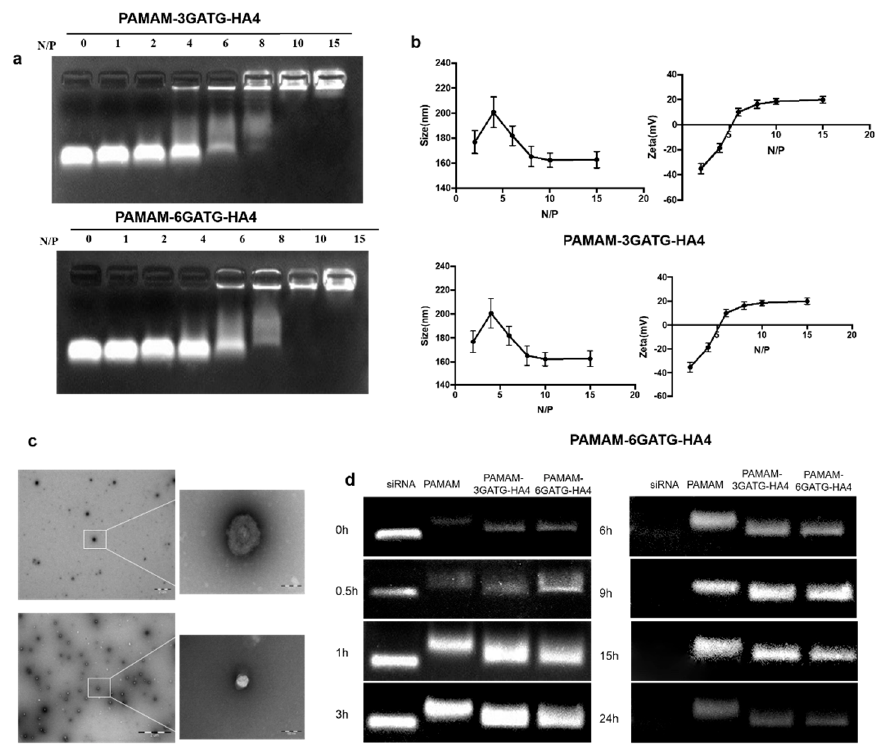
Figure 2. ( a ) Agarose gel electrophoresis of PAMAM-3GATG-HA4/siRNA and PAMAM-6GATG- HA4/siRNA nanocomplexes at different N/P ratios. ( b ) Particle size and zeta potential of PAMAM-3GATG-HA4/siRNA and PAMAM-6GATG-HA4/siRNA nanocomplexes at different N/P ratios. siRNA concentration in nanocomplexes was 100 nM. ( c ) Transmission electron microscopy (TEM) images of PAMAM-3GATG-HA4/siRNA and PAMAM-6GATG-HA4/siRNA nanocomplexes. The scale was 2 μ m in the original and 100 nm in the magnified image. ( d ) Serum stability of nanocomposites at 37 °C for 24 h. Results are expressed as mean ± SD ( n = 3).